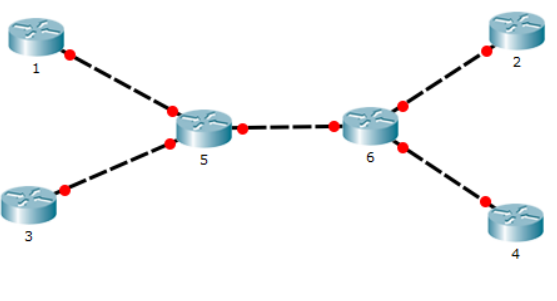
Figure 2. Two nodes pairs are competing for